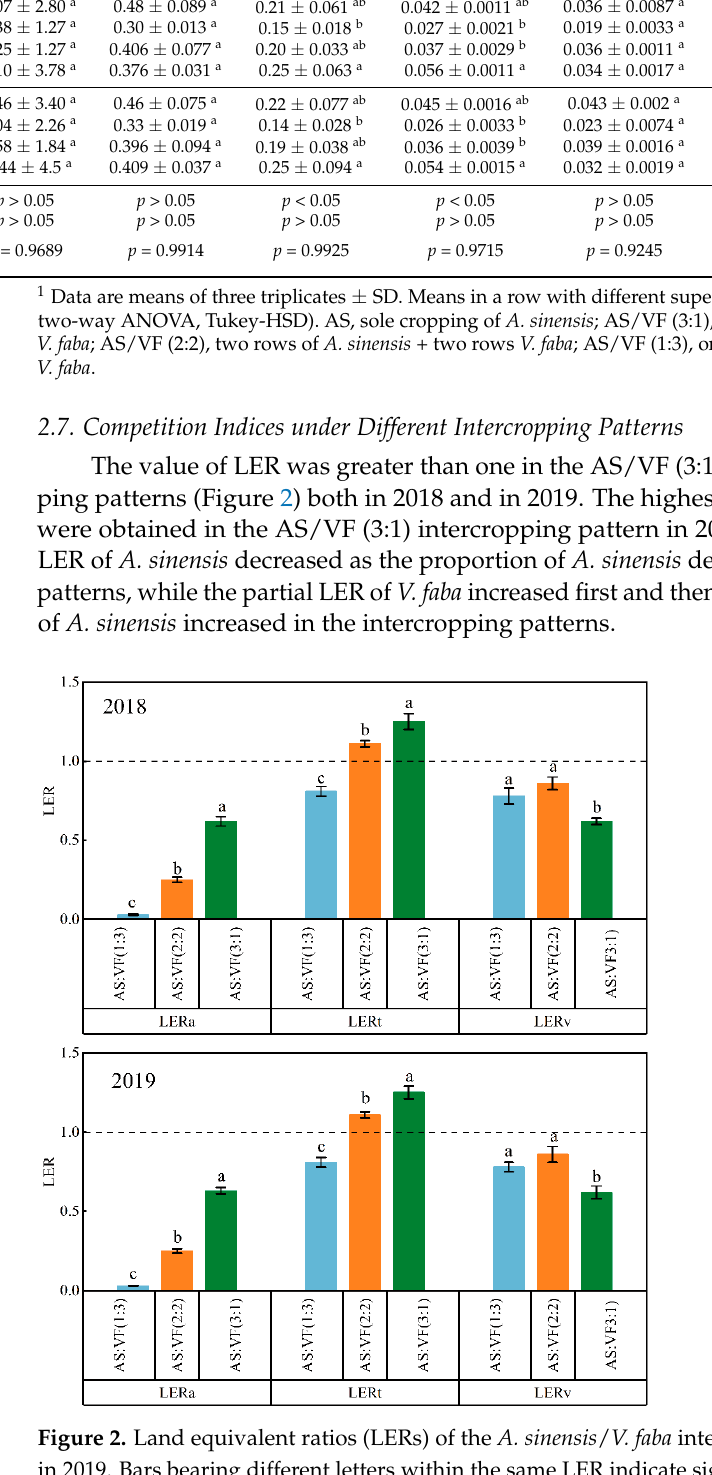
Figure 2. Land equivalent ratios (LERs) of the A. sinensis / V. faba intercropping patterns in 2018 and in 2019. Bars bearing different letters within the same LER indicate significance at p < 0.05. Error bars epitomize the standard deviation of the means. The dashed lines denote an LER equal to 1. AS/VF (3:1), three rows of A. sinensis + one row V. faba ; AS/VF (2:2), two rows of A. sinensis + two rows V. faba ; AS/VF (1:3), one row of A. sinensis + three rows of V. faba